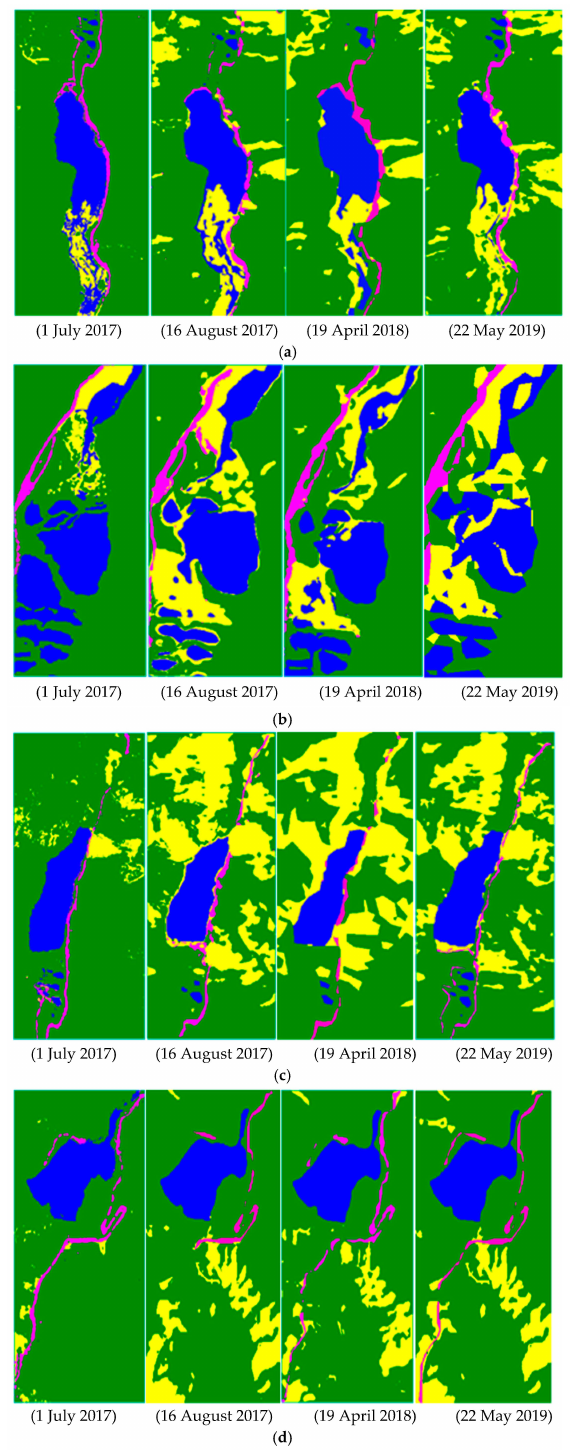
Figure 2. ( a ) Remote sensing images in different periods before and after the Jianzhu Sea earthquake. ( b ) Remote sensing images of different periods before and after the Sparks Sea earthquake. ( c ) Remote sensing images in different periods before and after the Panda Sea earthquake. ( d ) Remote sensing images in different periods before and after the Wuhua Sea